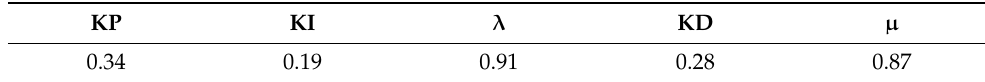
Table 1. Parameters for FOPID controller.